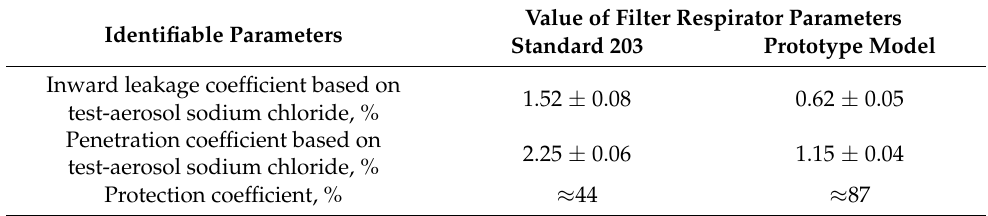
Table 6. Experimental group member number of the manufactured FDR model and the Standard 203 half